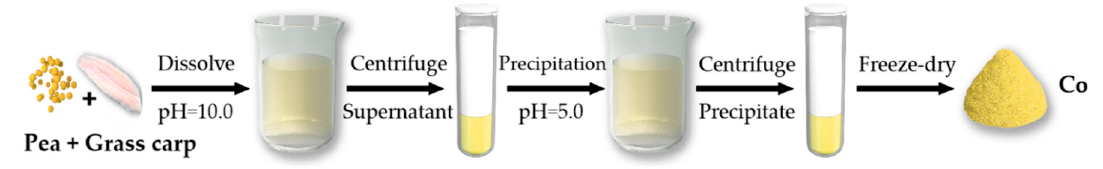
Figure 1. Schematic diagram of the preparation of co-precipitated dual-protein (Co). Compared to soybean, pea (Pisum sativum L.) has almost no sensitisation and trans- genic source risk, which has recently drawn significant attention to pea protein [12]. Peas are one of the world’s most widely planted and consumed legumes, with a global output of 14.64 million tonnes in 2020 [13]. Peas contain 20–30% protein, 65–80% globulin and 10– 20% albumin. They are rich in lysine and have a high nutritional value but lack methio-